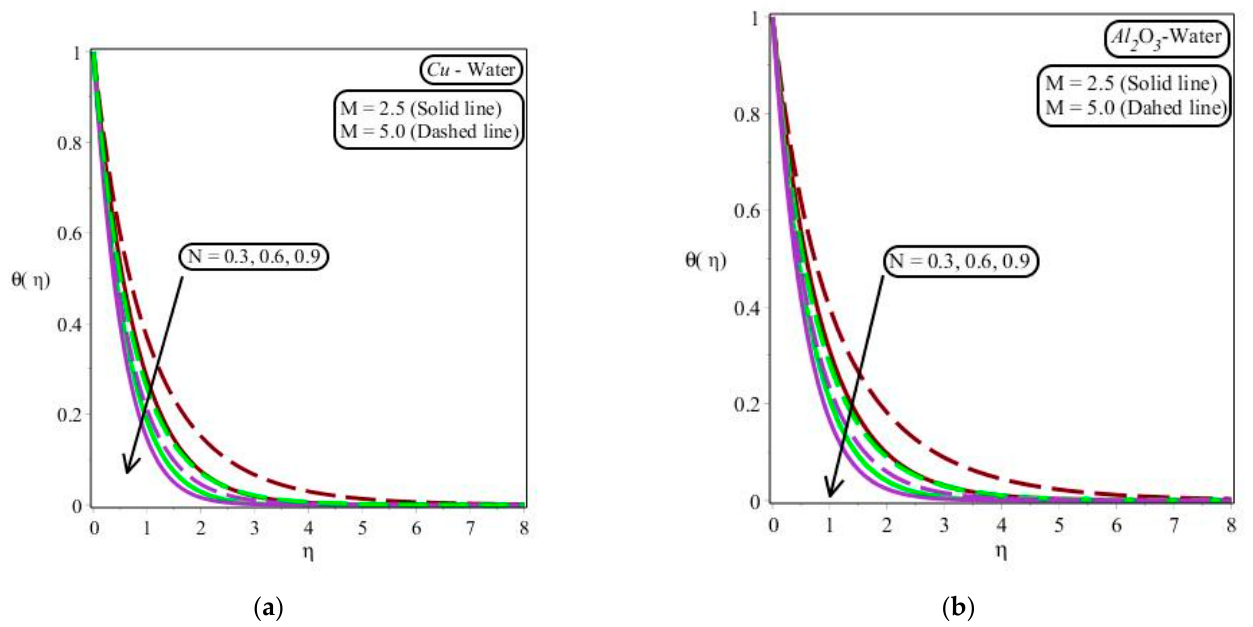
Figure 6. ( a , b ) Impact of β on temperature profile with K 1 = 0.7, γ = 𝜋/4 , and M = 0.2.